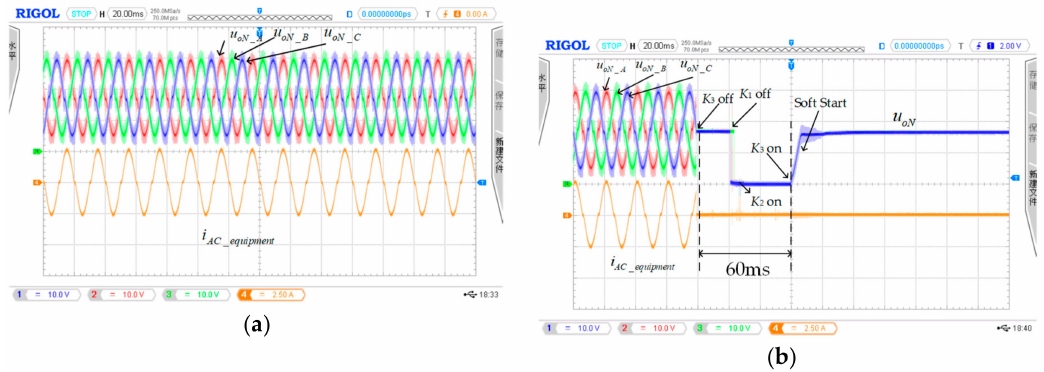
Figure 19. PR port voltage and current under. ( a ) DC Load Mode Steady State; ( b ) Switch from DC Load Mode to AC Load Mode.